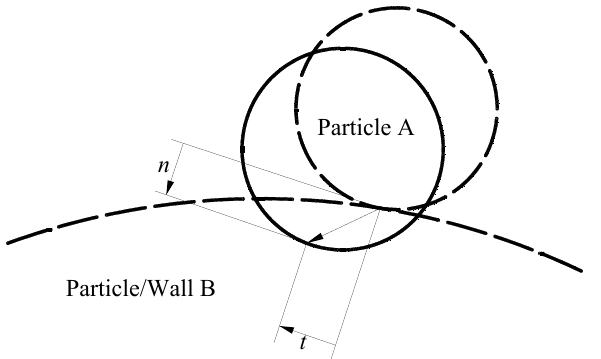
Figure 1. Schematic diagram of particle-particle/wall contact process where n is the normal displacement and t is the tangential displacement.